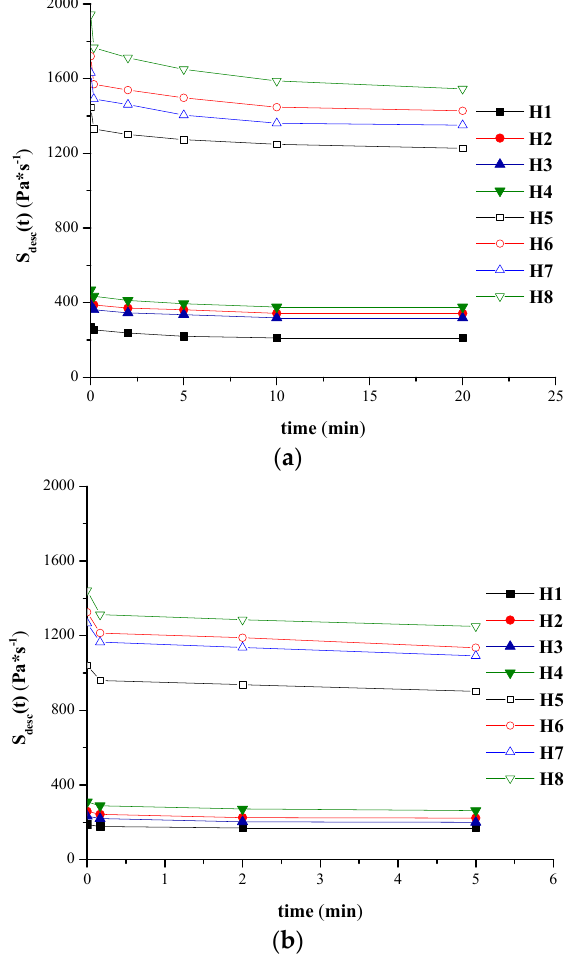
Figure 4. ( a ) S bw (t) values vs. different stirring times at maximum rotational speed for hydrogels H1-H8 analyzed at: ( a ) 23 °C; ( b ) 37 °C.